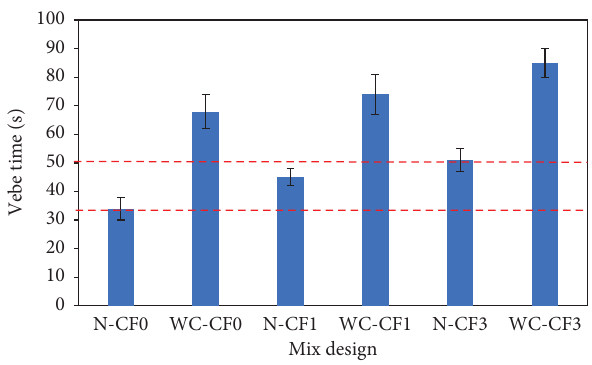
Figure 2: Vebe time of the mixtures.